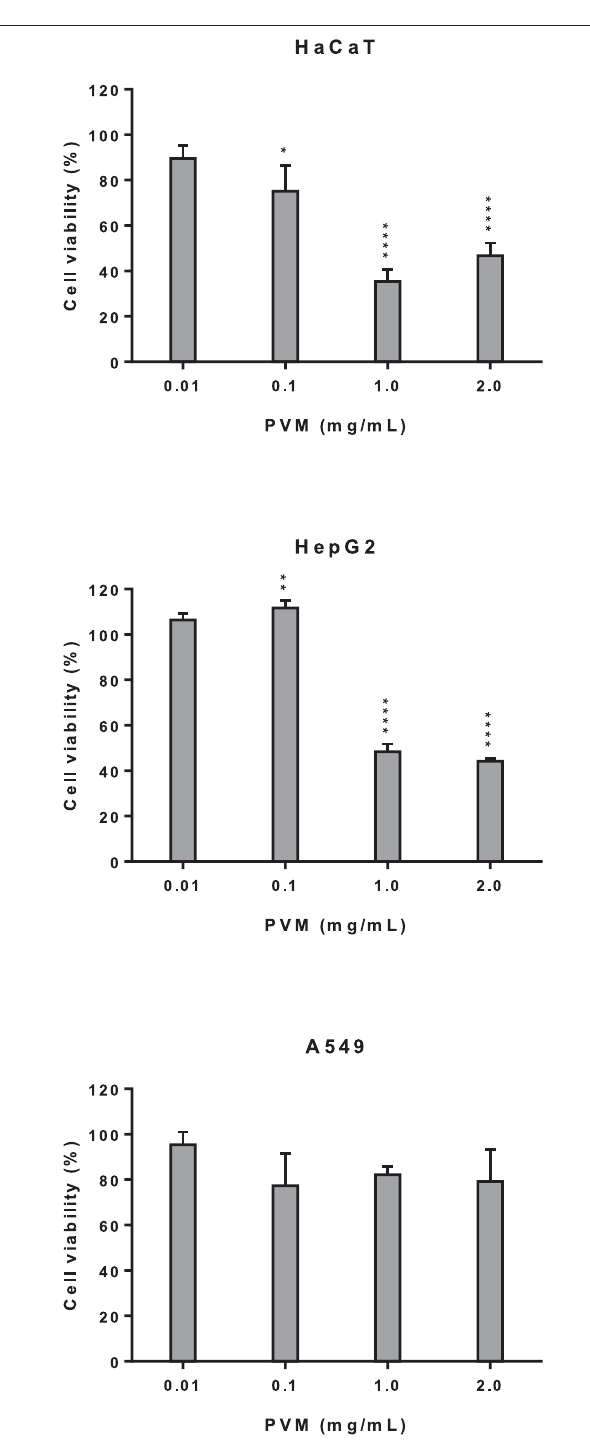
Frontiers in Pharmacology |